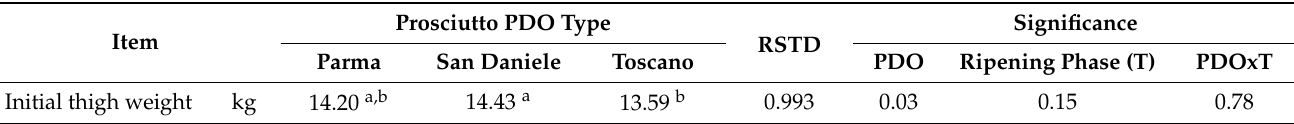
Table 1. Weight of green thighs which produced the experimental hams, averaged as prosciutto PDO type marginal means.